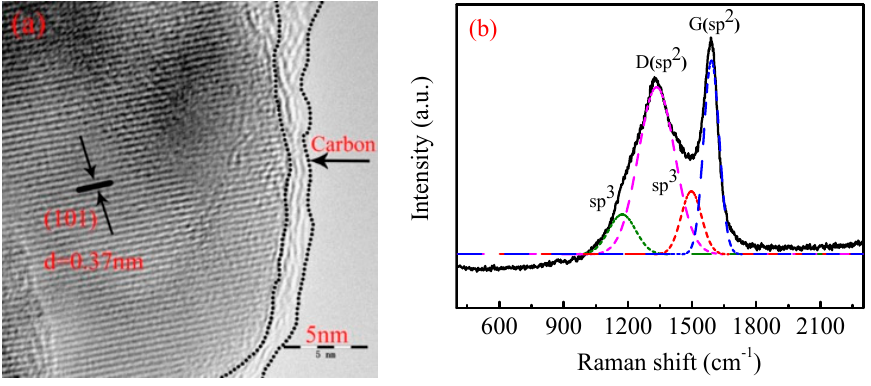
Figure 5. ( a ) HR-TEM image; and ( b ) Raman spectra of the prepared LiMnPO 4 /C.